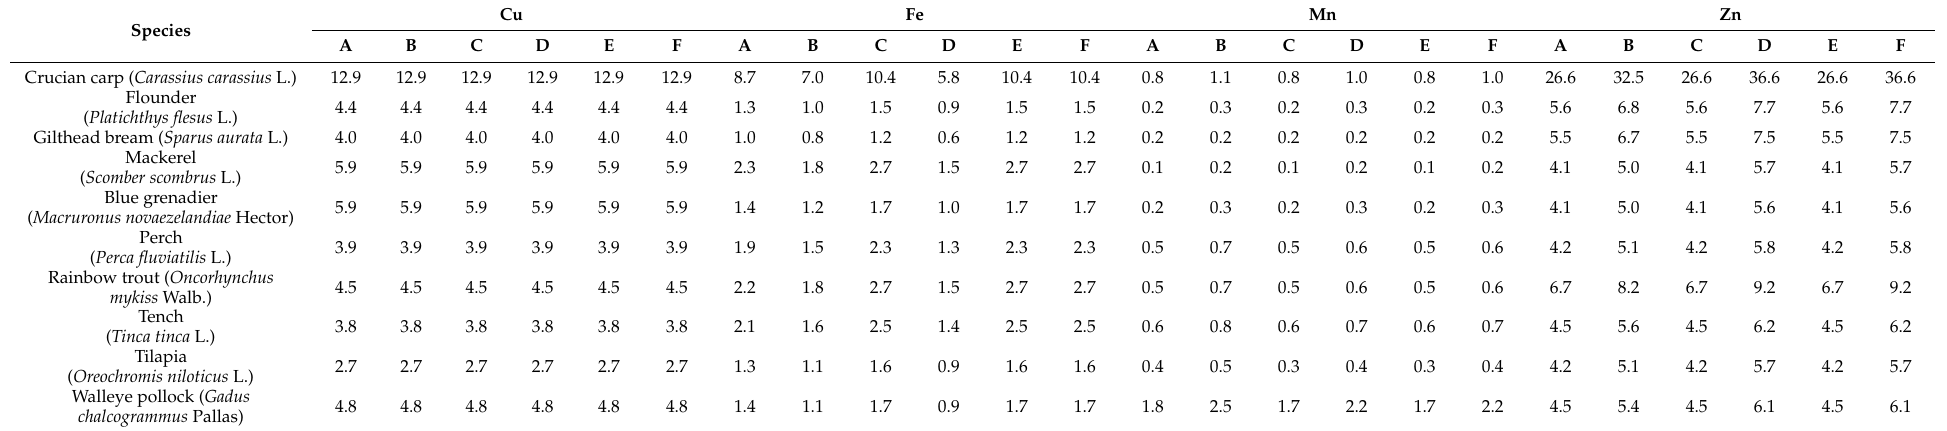
Table 2. Coverage of the demand (%) for Cu, Fe, Mn and Zn after consuming an average portion of fish (150